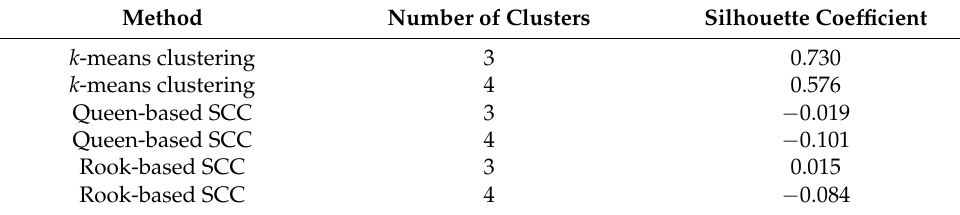
Table 4. Silhouette coefficients of clustering